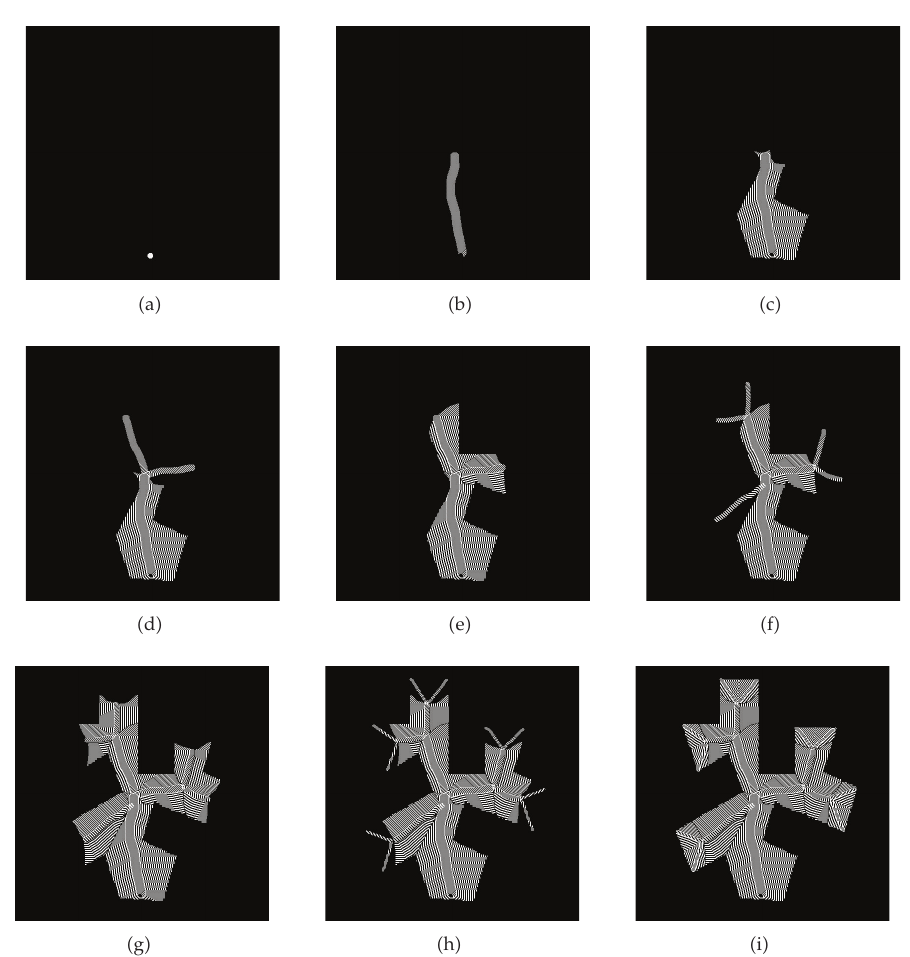
Figure 7: Result of simulation at di ff erent time instances. (cid:2) a (cid:3) inlet point or set S 1 from which the water flows into tidal basin, (cid:2) b (cid:3) water propagation from S 1 (cid:2) marker set (cid:3) into mask set (cid:2) S 2 (cid:3) , (cid:2) c (cid:3) flow fields propagating from marker-set S 2 into set S 3 —nonchannelized set or the influence zone of set S 2 —that acts as a mask set, (cid:2) d (cid:3) set S 4 the mask set that gets flooded due to the water flowing from the marker set S 1 after sets S 2 and S 3 are completely flooded, (cid:2) e (cid:3) set S 5 —nonchannelized (cid:2) influence (cid:3) zone of set S 4 gets flooded from the marker set S 4 , (cid:2) f (cid:3) set S 6 that acts as mask set to allow the water flows from the extreme tips of set S 4 , (cid:2) g (cid:3) set S 7 the influence zone of the channelized set S 6 —here the mask set S 7 would be progressively flooded from the water flowing from the marker set S 6 , (cid:2) h (cid:3) channelized mask set S 8 in which the water flows from the extremities of set S 6 , and (cid:2) i (cid:3) mask set S 9 —influence zone of set S 8 —gets progressively flooded due to water flowing from set S 8 that acts as a marker set to fill the water in its corresponding mask set S 9 .